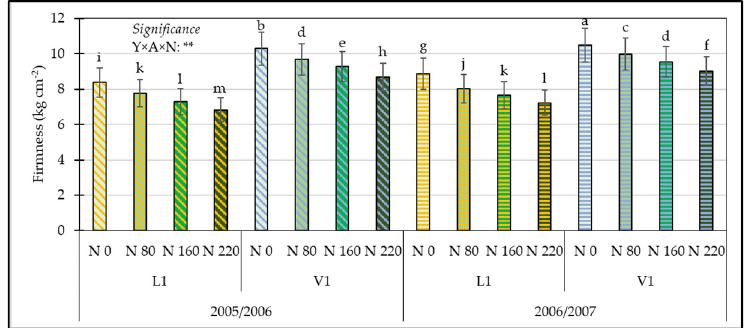
Figure 3 . Influence of the interaction Y × A × N on bulb firmness. Means with the same letter are not significantly different at p ≤ 0.05 according to Tukey’s test. Bars represent the standard error. ** = significant at p ≤ 0.01; Y = Year; A = Accession; N = nitrogen; L1 = Landrace (Bianca Calda di Comiso); V1 = Commercial Variety (Bianca di Maggio); N 0 = No-Nitrogen Fertilization; N 80 = fertilization with 80 kg N ha − 1 ; N 160 = fertilization with 160 kg N ha − 1 ; N 220 = fertilization with 220 kg N ha − 1 .